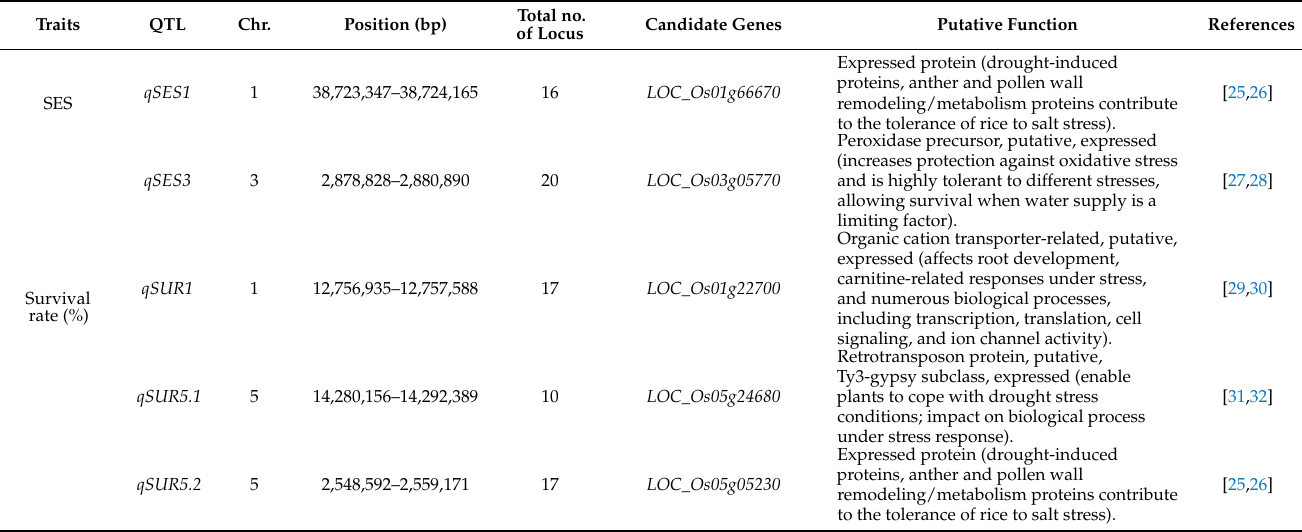
Table 3. Possible candidate gene loci within the QTL regions illustrating putative functions and